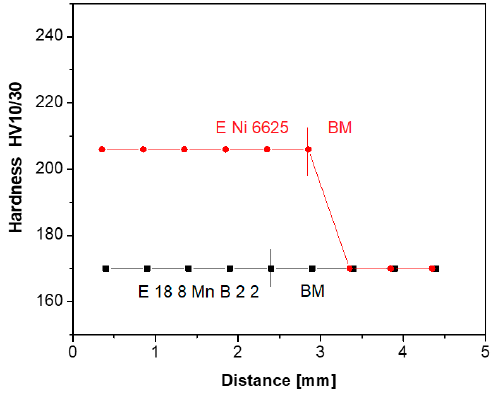
Figure 12. Hardness of the welded clads.